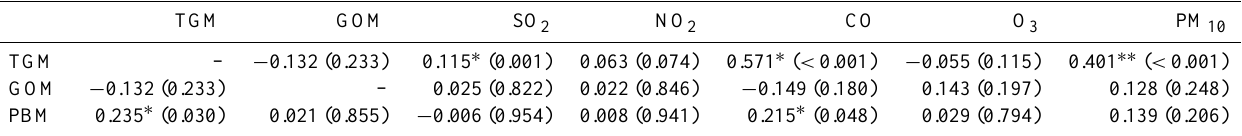
Table 3. Correlation coefficients and p values (in parenthesis) for speciated Hg with other pollutants for the whole sampling period. Corre- lation coefficients with an asterisk indicate a statistically significant relationship at α = 0 . 05.